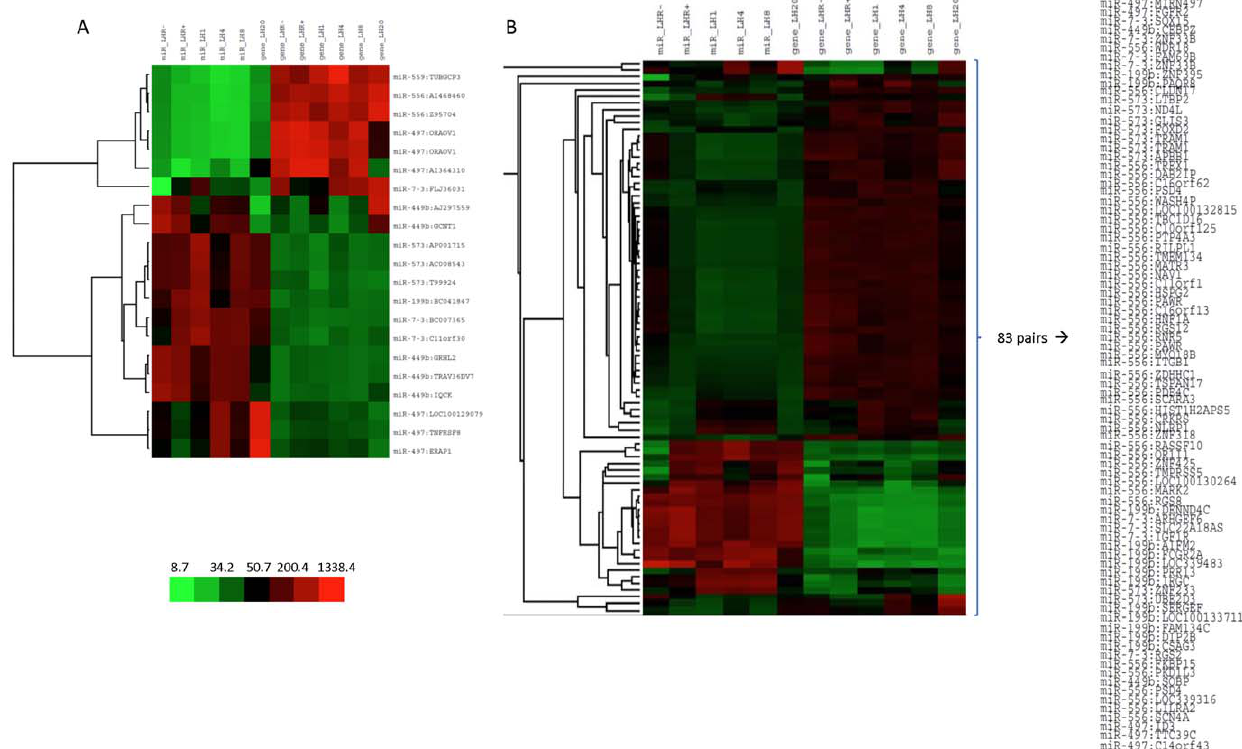
Figure 4. The heatmap of the most correlated expressions between microRNA and mRNAs. A : pairs with the highest negative correlation in expression, and B : pairs with the highest positive correlation in expression (|rho| . 0.99).